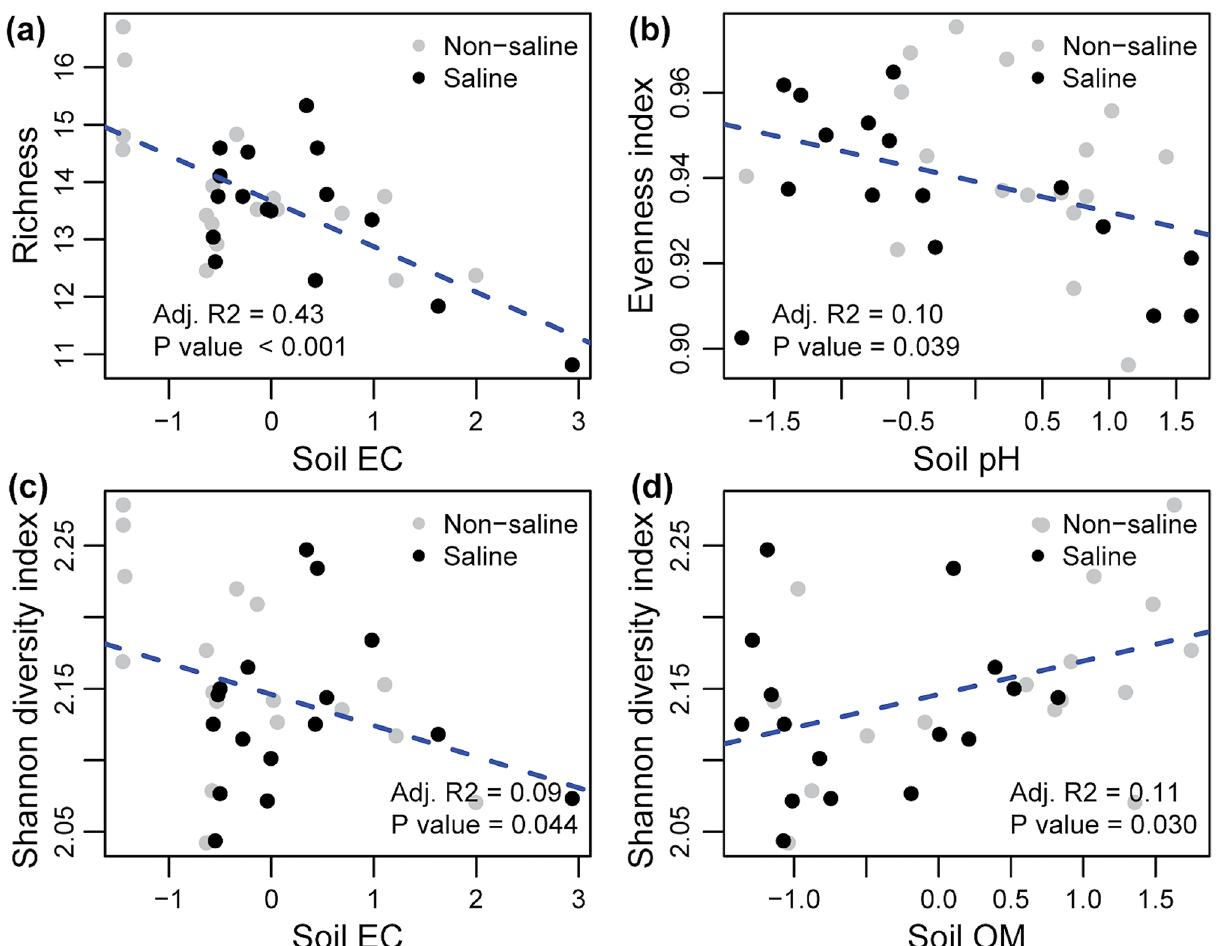
Figure 3. Linear regression analyses between bacterial diversity measures and soil chemistry. Relationship between ( a ) bacterial richness; ( b ) evenness index; and ( c,d ) Shannon diversity index with environmental metadata. The statistical inference (R 2 and P values) and regression line (blue colour) are highlighted within each panel. EC electrical conductivity (dS/m), OM organic matter